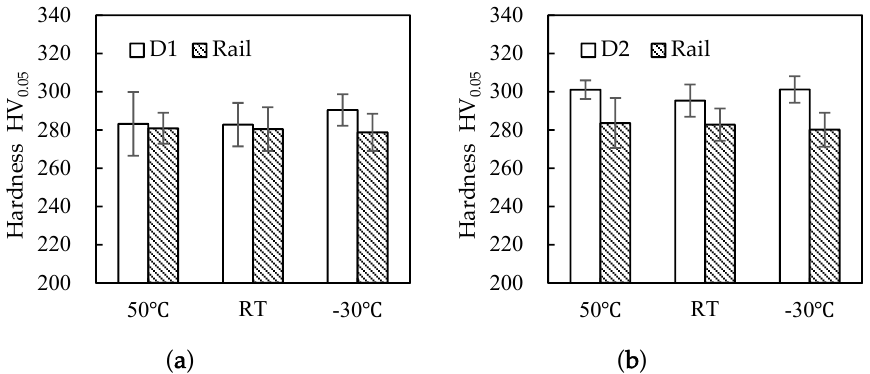
Figure 7. Surface hardness of wheel and rail samples before the experiment. ( a ) D1 friction pair; ( b ) D2 friction pair.